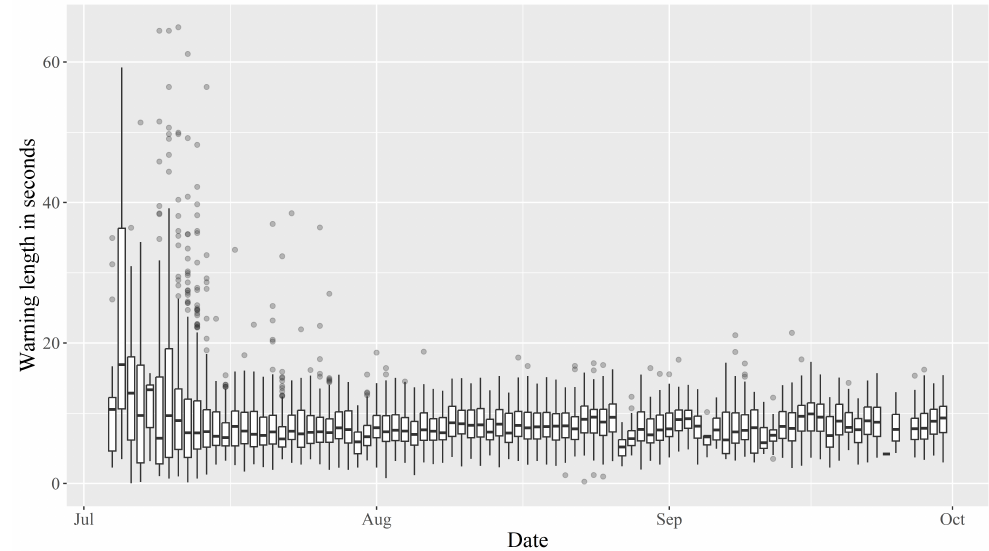
Figure 6. Warning duration in seconds over time for all animals represented as a series of boxplots showing min, Q1, median, Q3 and max. Outliers calculated as 1.5 times IQR. The median number of impulses an animal received per warning in the beginning was approximately 0.5, but immediately trended downwards before reaching a median of 0 in late August (Figure 7).